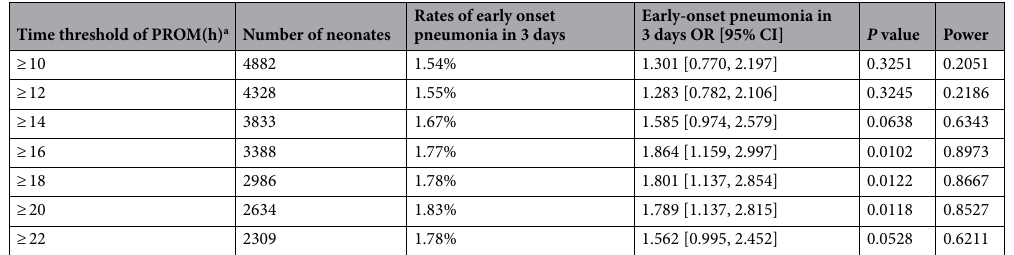
Time threshold of PROM(h) a Number of neonates